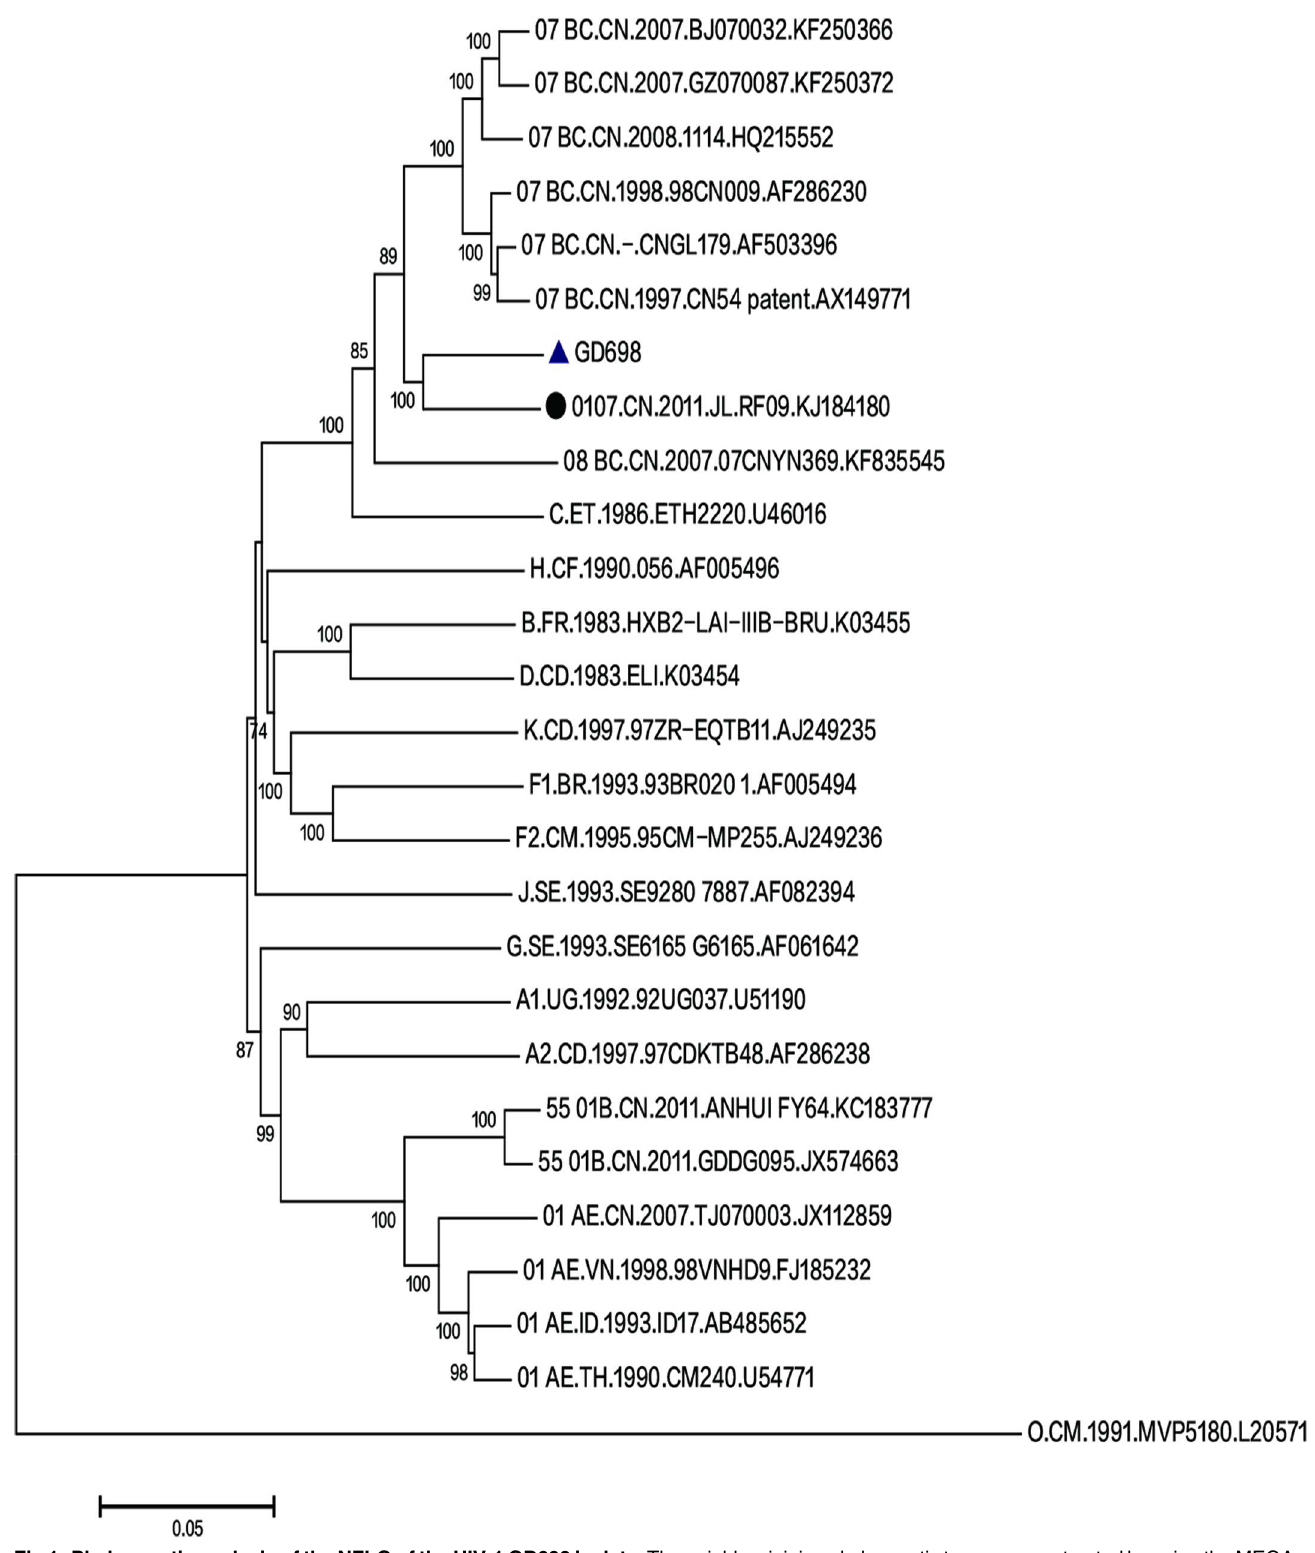
Fig 1. Phylogenetic analysis of the NFLG of the HIV-1 GD698 isolate. The neighbor-joiningphylogenetic tree was constructed by using the MEGA 6 software package.All the reference strains of subtype A–D, F–H, J, K, CRF01_AE, CRF07_BC, CRF55_01Band CRF08_BC were retrieved from the